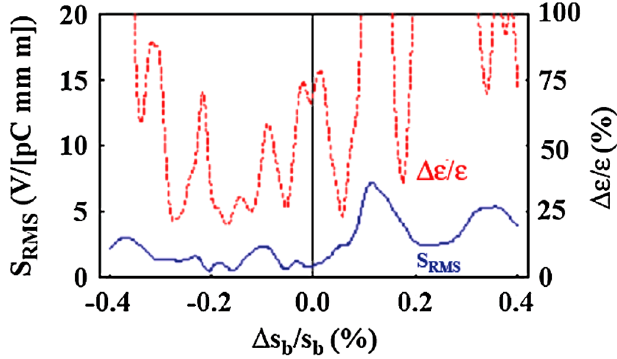
FIG. 16. (Color) Emittance dilution (illustrated by the red dashed curve) versus the percentage change in the bunch spac- ing. Also shown is the corresponding rms of the sum wakefield (by the solid blue